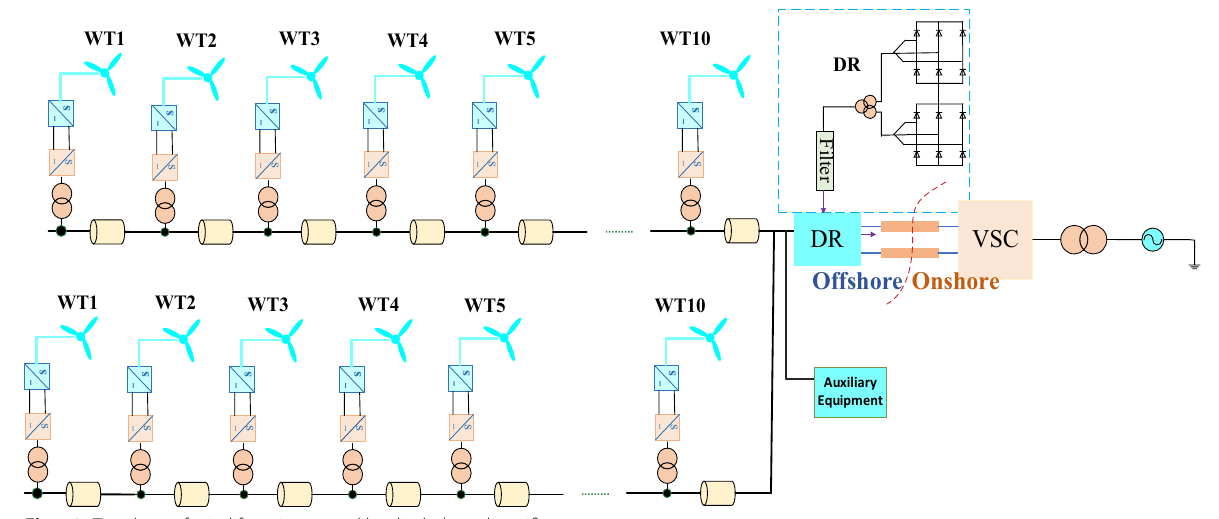
Fig. 12 Topology of wind farm integrated by diode-based rectifier